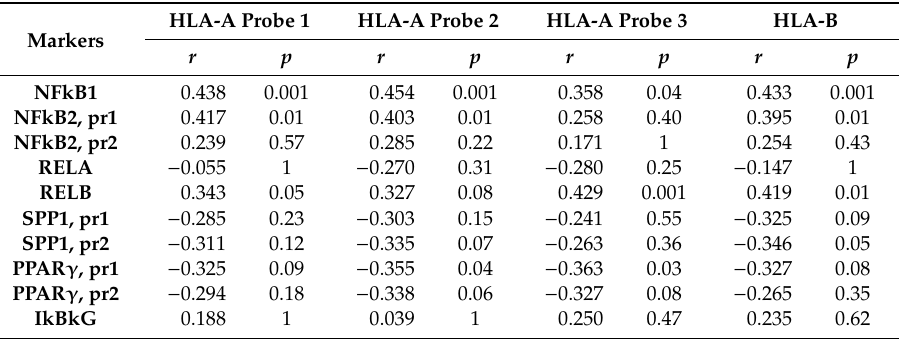
Table 1. Correlation between mRNA expression levels of di ff erent NFkB pathway molecules with mRNA expression markers of HLA-A and HLA-B. r = two-tailed Spearman correlation coe ffi cient. p ≤ 0.05 is considered significant. Bonferroni correction was